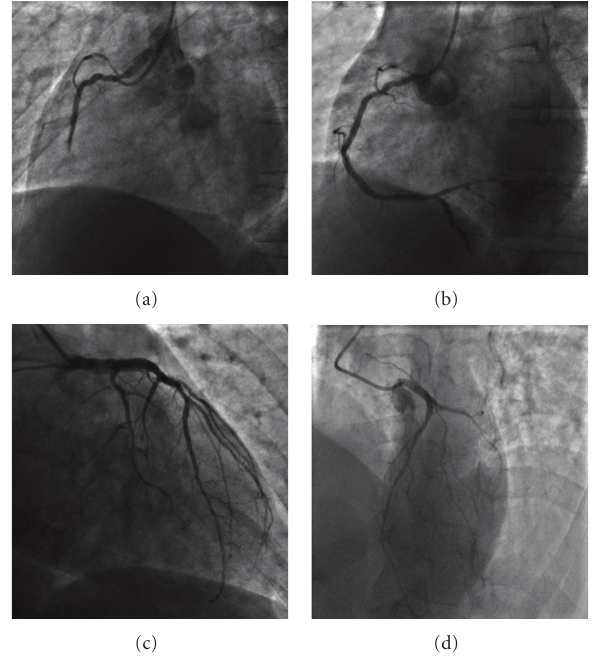
Figure 1: Initially, the coronary angiography showed an acute thrombotic occlusion on the second segment of the right coronary artery (Panel (a)). The patient underwent angioplasty and stenting with a final good result (Panel (b)). Coronary angiography revealed a severe stenosis on a minor circumflex coronary artery (Panel (c)). There were many di ff use lesions on the left anterior descending coronary artery and his branches without significant stenosis (Panel